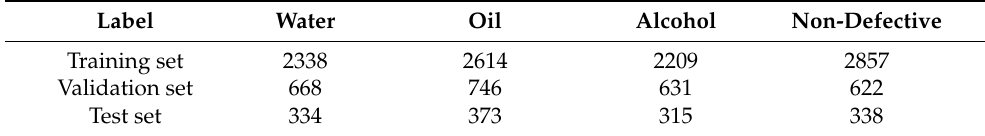
Table 1. Sample sizes of each label